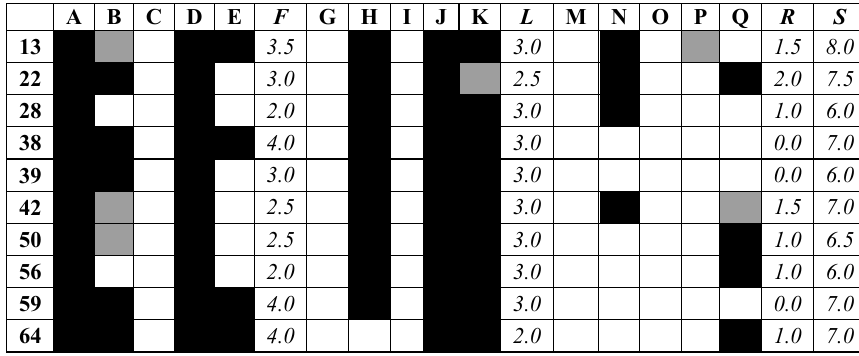
Figure 7. Docking position of best candidate, compound 39 (Table 2) in the binding site of Leishmania arginase homology model with marked intermolecular interactions. Green lines: hydrogen bonds, purple: aromatic/hydrophobic interactions